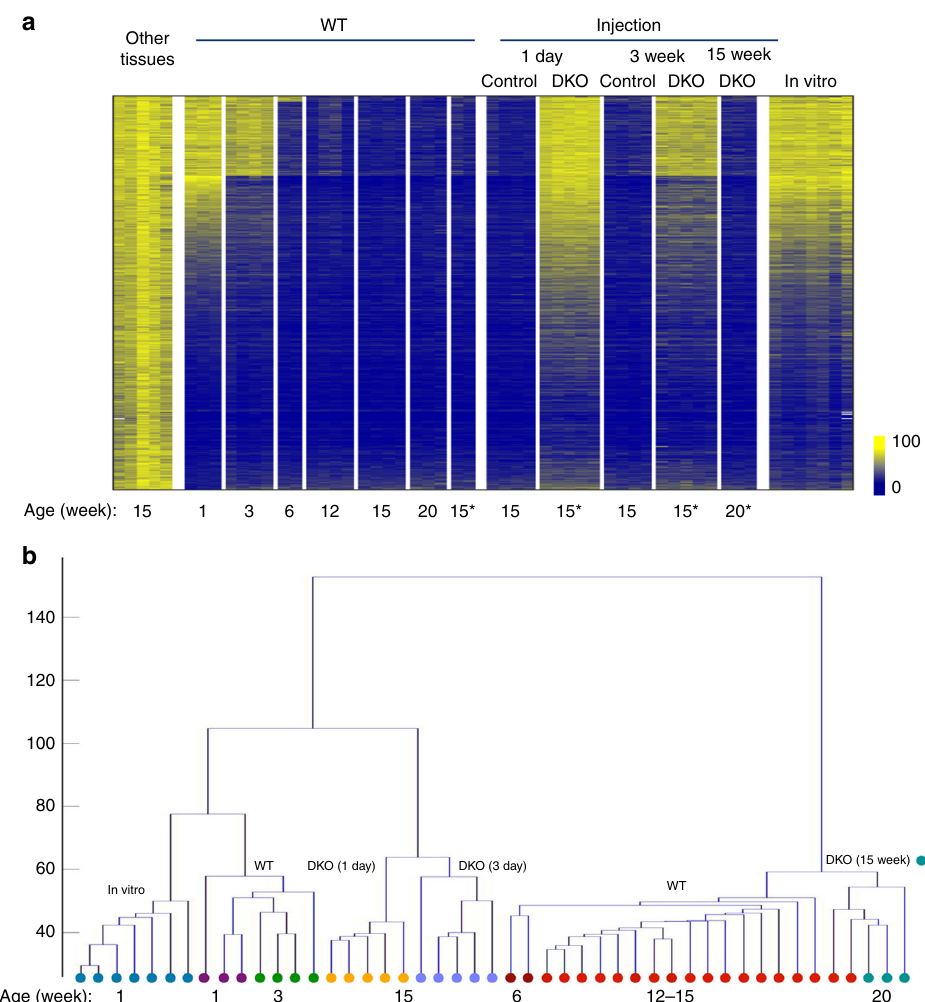
Fig. 1 Postnatal demethylation in the liver. a Heatmap of speci fi cally undermethylated 100 bp regions ( n = 9000) measured in hepatocytes from WT or Tet2 F /Tet3 F (*) animals at different ages and in other tissues (lung, heart, neutrophils, brain, fat) by RRBS. Animals were injected with AAV8-expressing Cre under the Tbg-Cre promoter at 1 day, 3 weeks, or 15 weeks (control or DKO). Note that there is only a slight degree of remethylation (<6%) in the 3-week DKO samples. Hepatocytes were also isolated from newborn mice and cultured in vitro for 3 weeks. b Unbiased hierarchical clustering analysis on the entire hepatocyte RRBS data set without selection for speci fi c sequences, including the injection controls and in vitro grown hepatocytes (1 week). Injected control samples are included in the 12 – 15 weeks